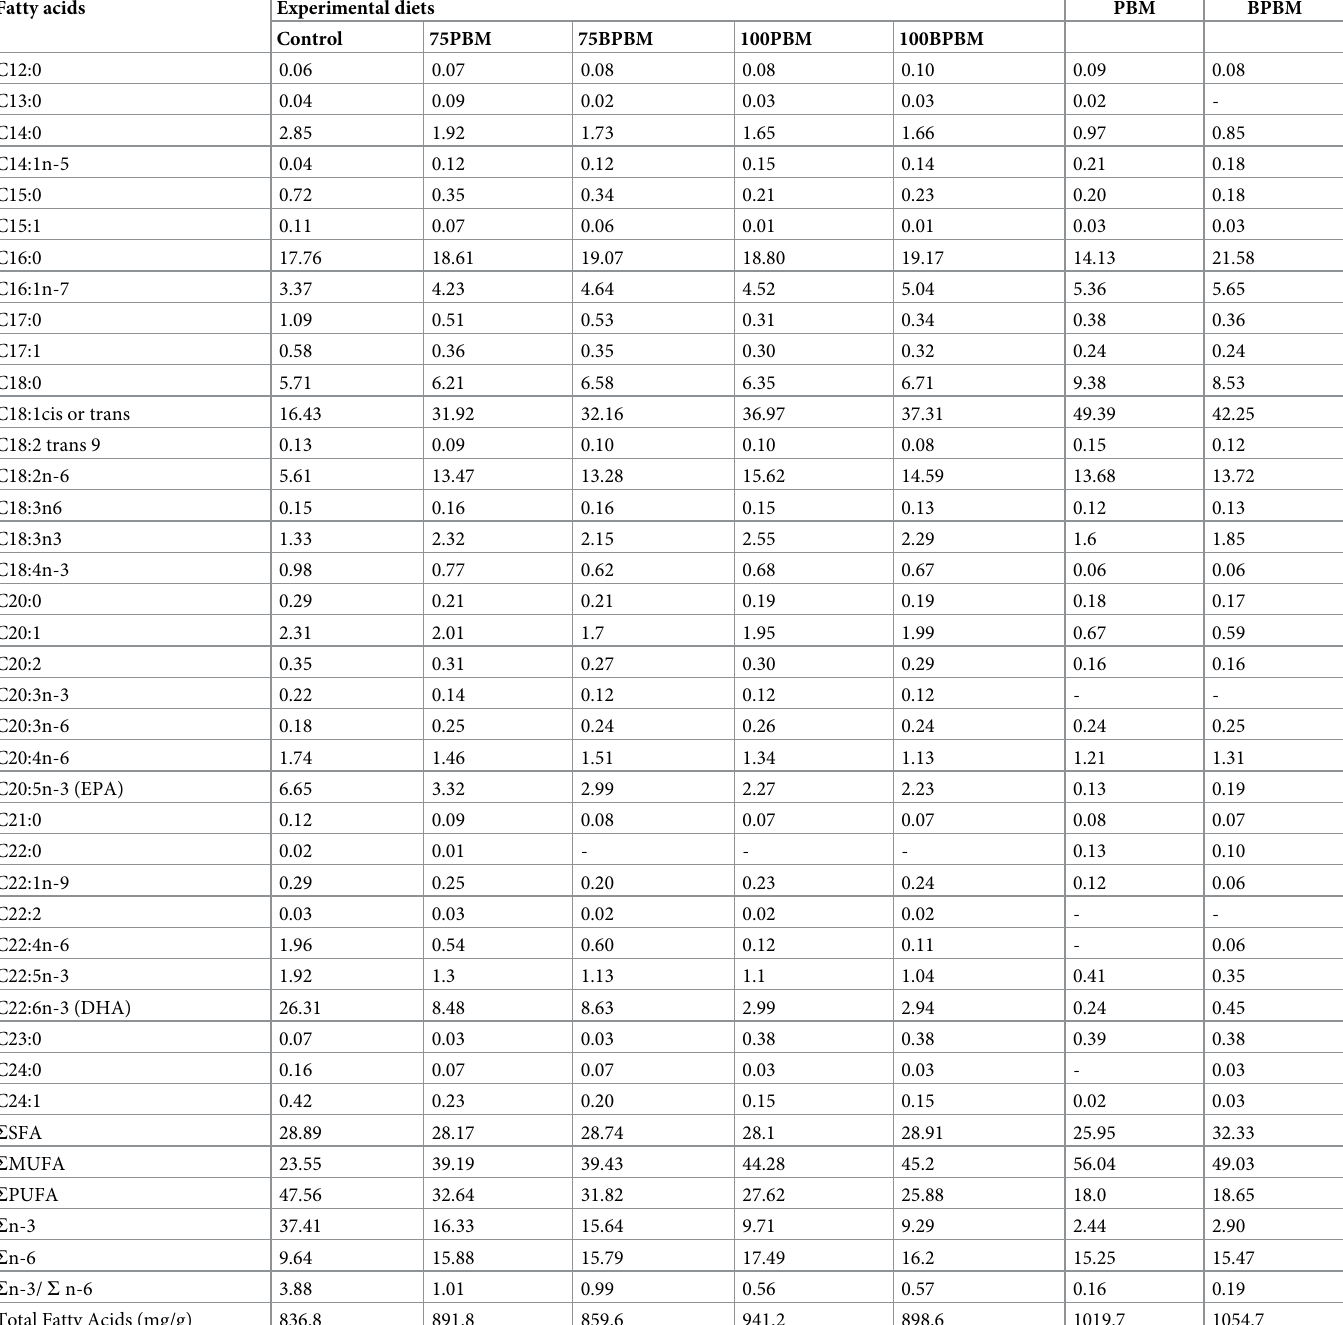
Table 3. The fatty acid composition (% of total fatty acids) and total fatty acid content (mg/g of lipid) of the five experimental diets and tested unprocessed and bio- processed PBM. Fatty acids Experimental